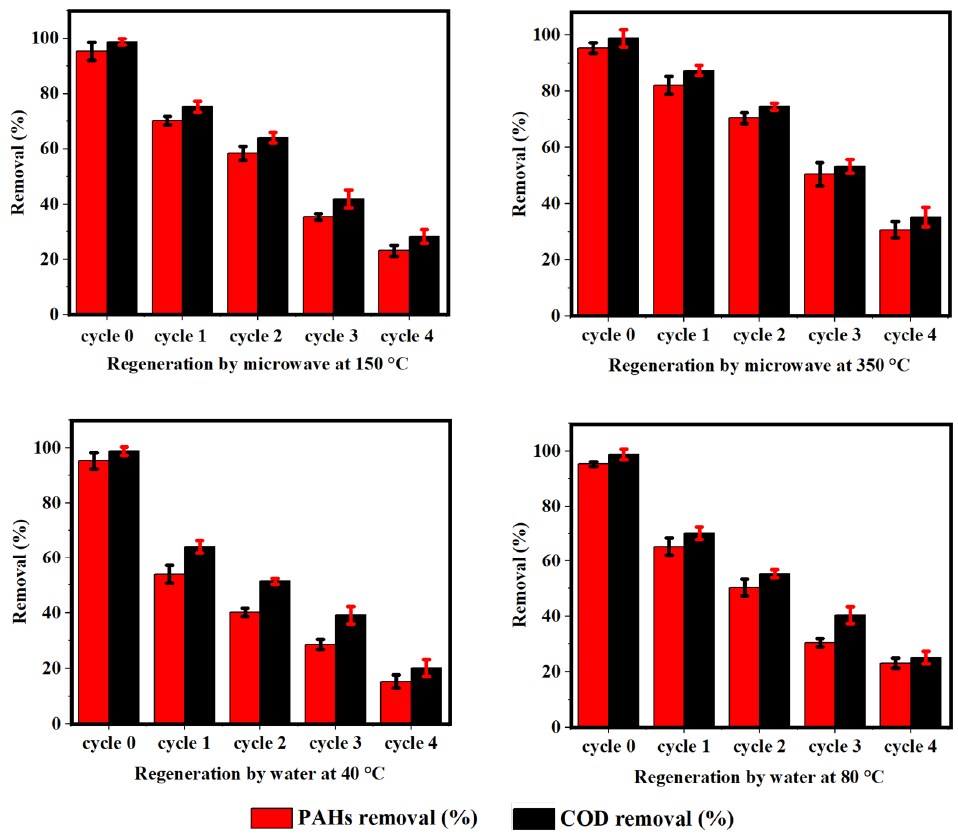
Figure 6. Regeneration study of PKSB for PAH and COD removal.